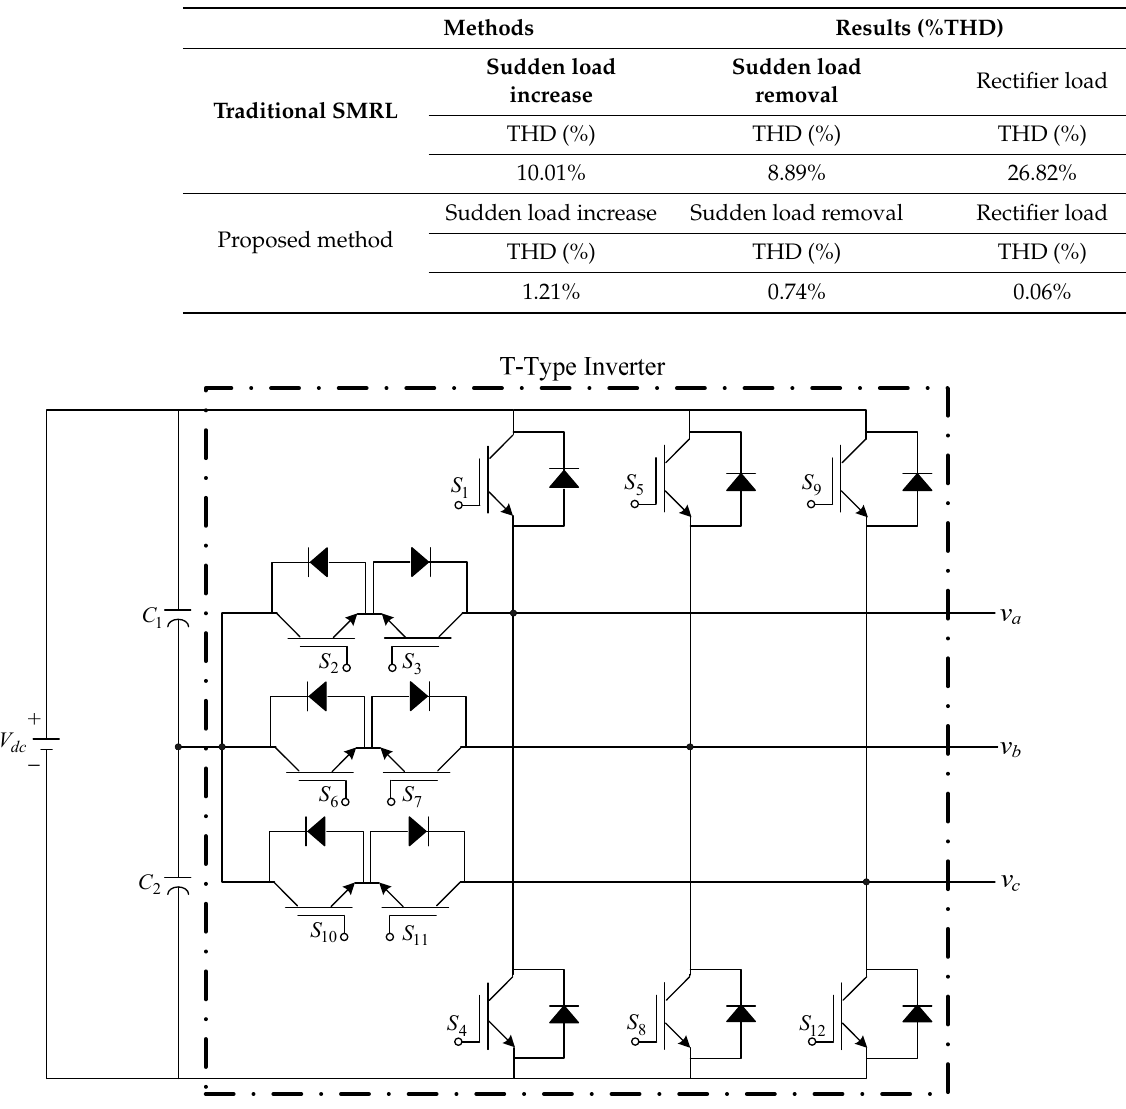
Table 3. Experimental AC output voltage total harmonic distortion (THD).